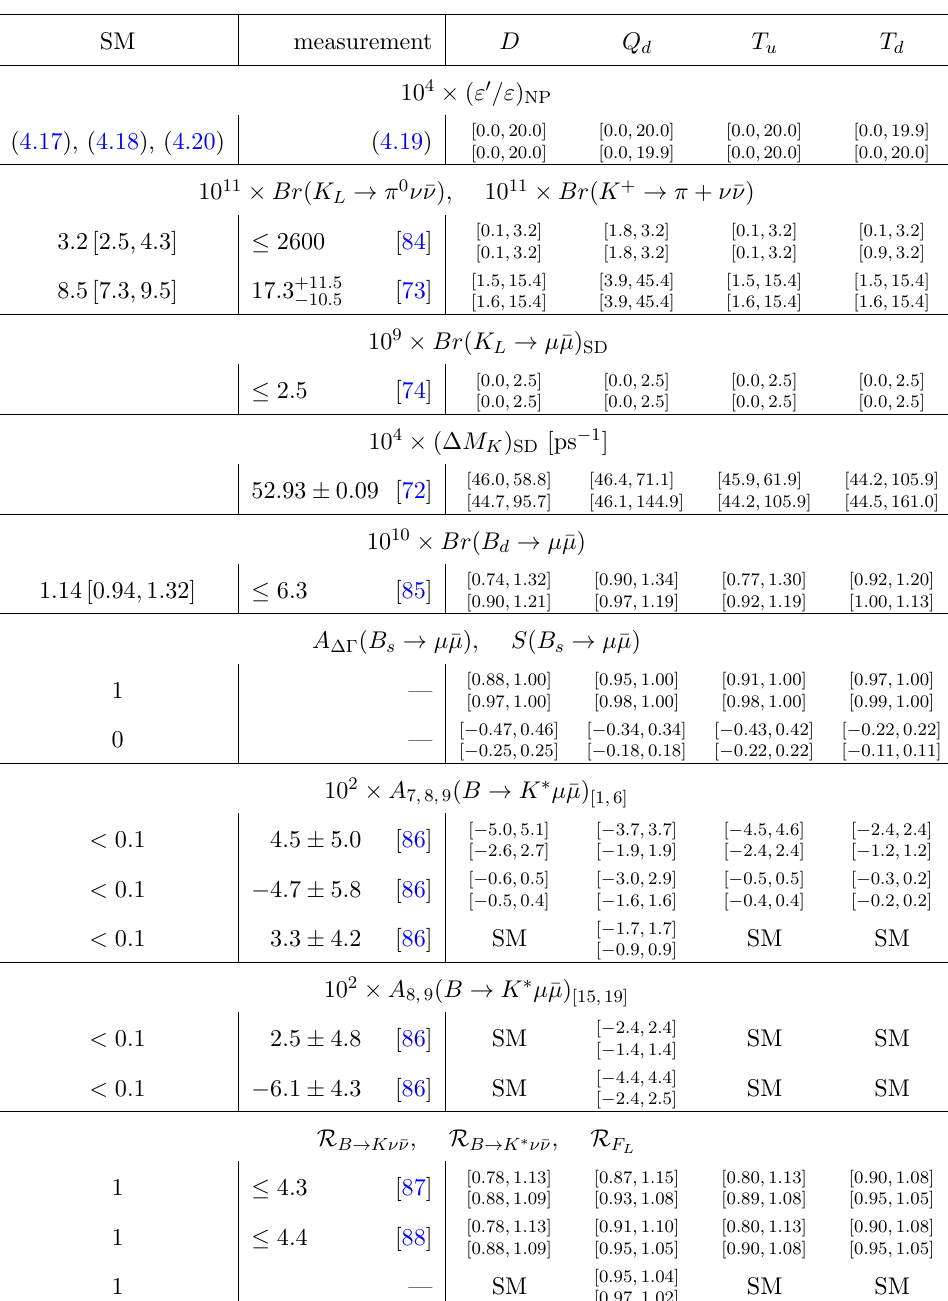
Table 10. Ranges still allowed for observables when varying (cid:3) ij of G 0 ((cid:8)) models in the 95% CL SM ranges for individual s d , b d and b s sectors for benchmark points BP1/BP2 [upper/lower]. ! ! ! Moreover ( " 0 =" ) NP is restricted as given in eq. (6.1). Entries denoted as \SM" have tiny or no deviations from the SM. Experimental upper bounds are given at 90%